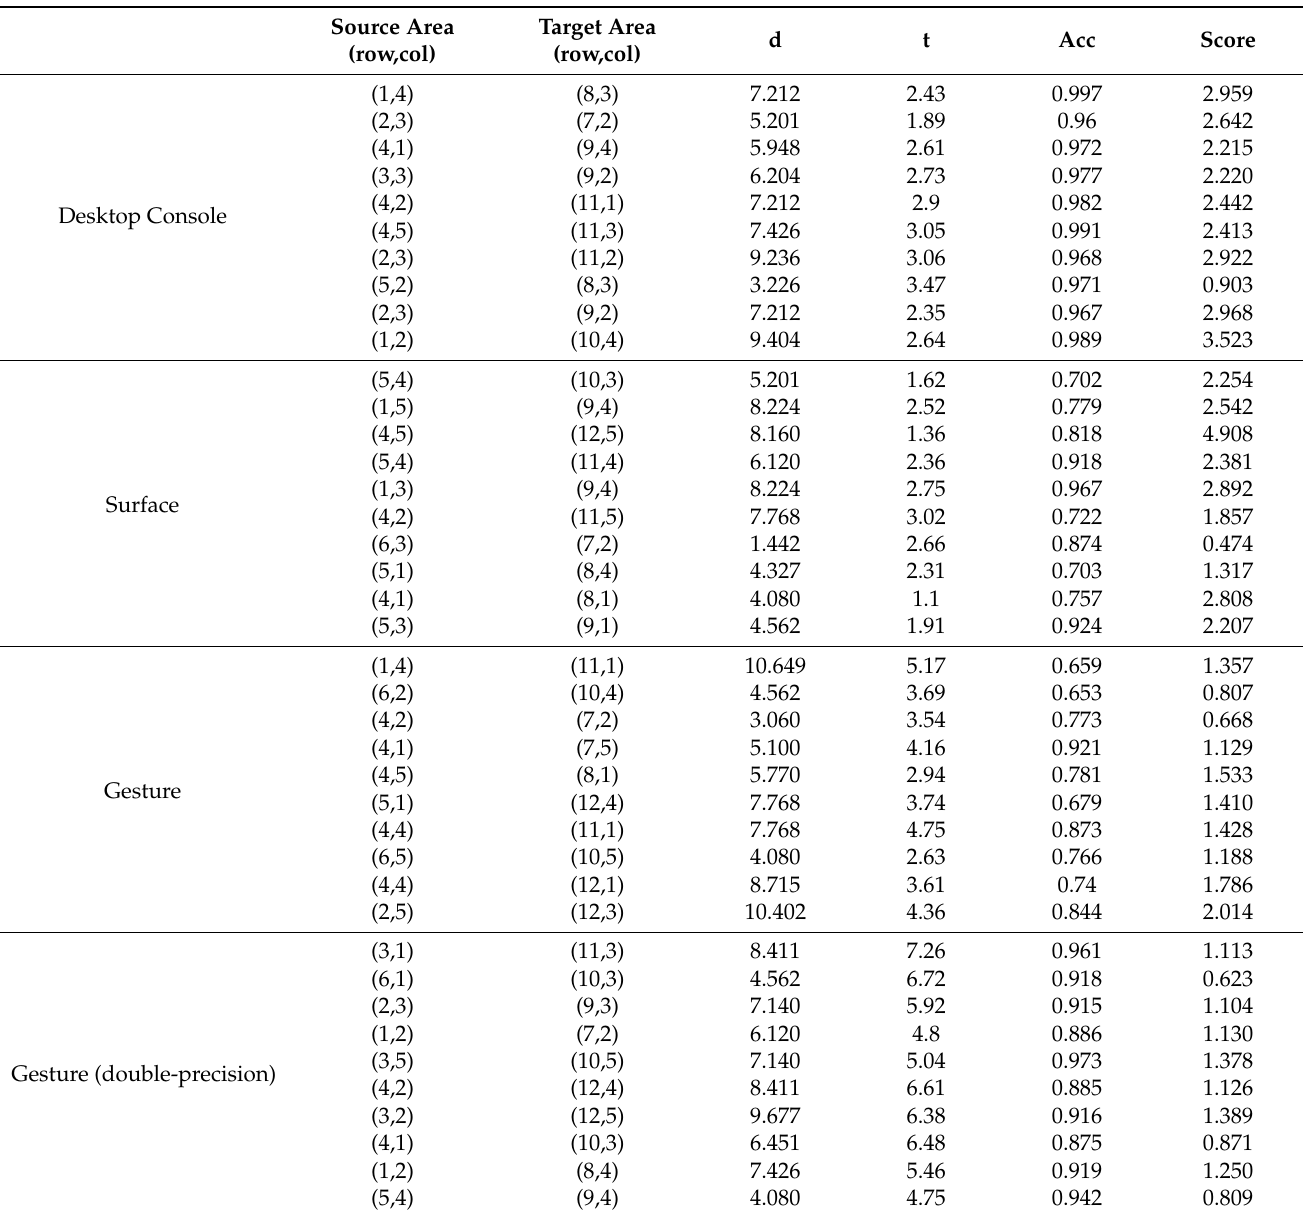
Table 2. Experimental results of movement task.